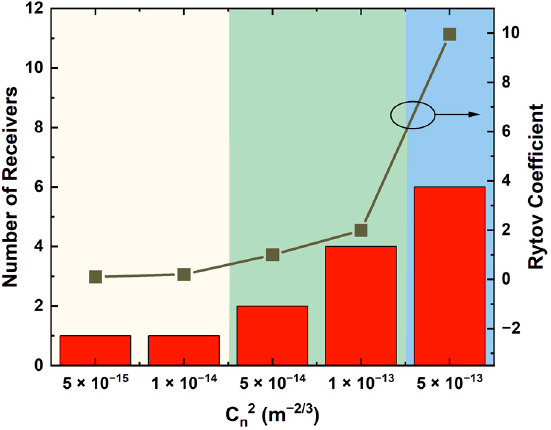
Figure 8. Required aperture number of receivers for the BER below 1 × 10 − 3 at the SNR of 6 dB.